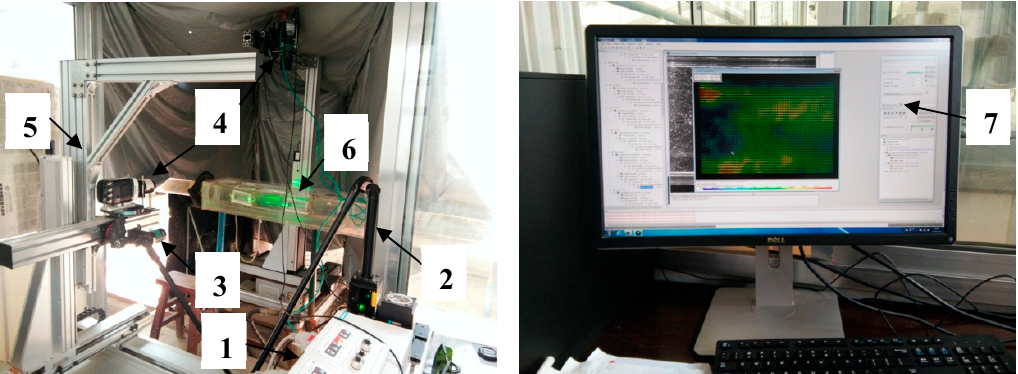
Figure 4. Particle-image-velocimetry (PIV) system test diagram. 1, synchronizer; 2, light guide arm; 3, laser; 4, Charge Coupled Device (CCD) camera; 5, coordinate frame; 6, square water jacket; 7, dynamic studio software.